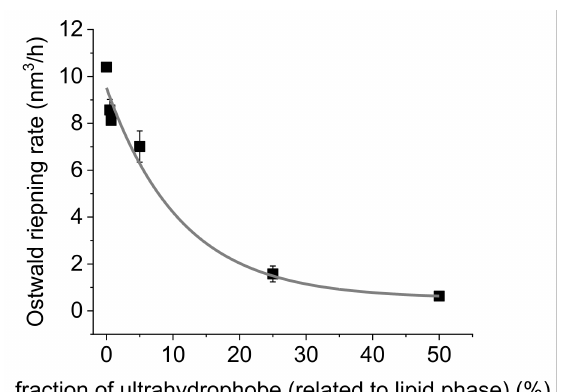
Figure 7. Ostwald ripening rates of osmotically stabilised MCT nanoemulsions as a function of the mass fraction of ultrahydrophobe (soybean oil). The mean of the values was fitted with an exponential function (R-square = 0.9998). Mean of 3 independent experiments ( n = 3) ± standard